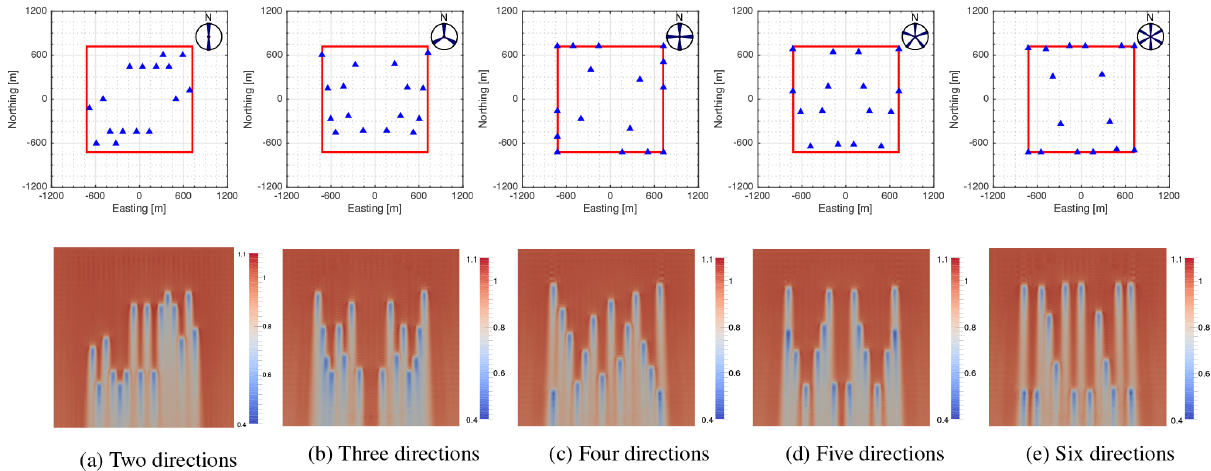
Figure 6. Optimal layouts (top row) and flow fields (bottom row) for five test cases with an increasing number of evenly weighted inflow directions. The wind roses in the upper right corner of each layout plot show the inflow directions used in the optimization. The blue triangles show the optimized turbine locations and the red square indicates the site boundaries. The velocities are normalized by the hub-height inflow velocity, which is 8ms − 1 in these simulations. Each of the flow fields are shown for a wind that blows from the north. Table 1. Relative efficiency of power production from the test cases compared to 16 turbines with no wake effects. Results from a “naïve” case with two parallel turbine rows and no layout optimization are also included to demonstrate the improvements achieved by the layout optimization. All unwaked Two-dir. naïve Two-dir. opt. Three-dir. opt. Four-dir. opt. Five-dir. opt. Six-dir. opt. 1.0 0.833 0.9854 0.953 0.960 0.948